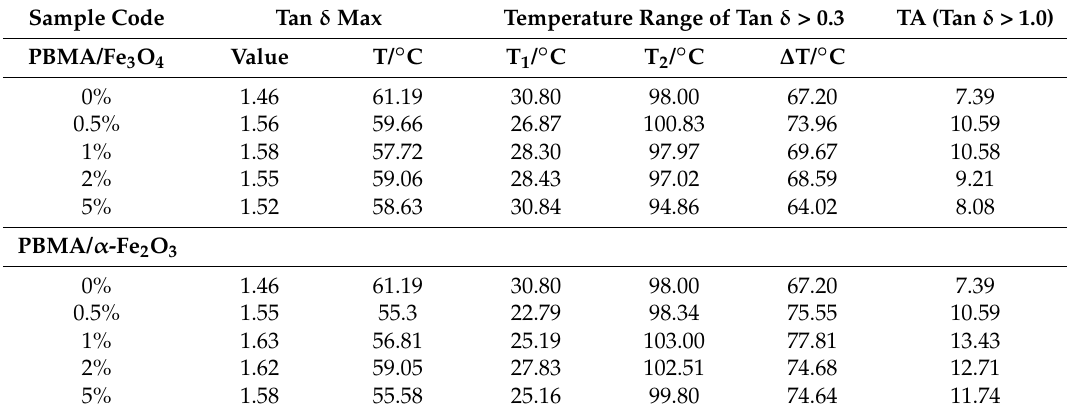
Table 3. The damping properties of PBMA/Fe 3 O 4 and PBMA/ α -Fe 2 O 3